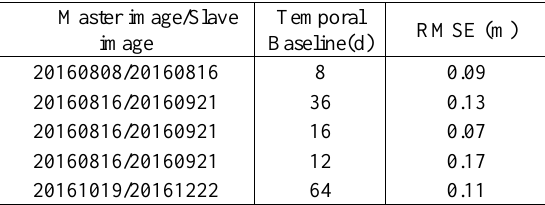
Table 2. The RMSE in stable zones of Shie glacier The RMSEs are 0.09, 0.13, 0.07, 0.17 and 0.11m for